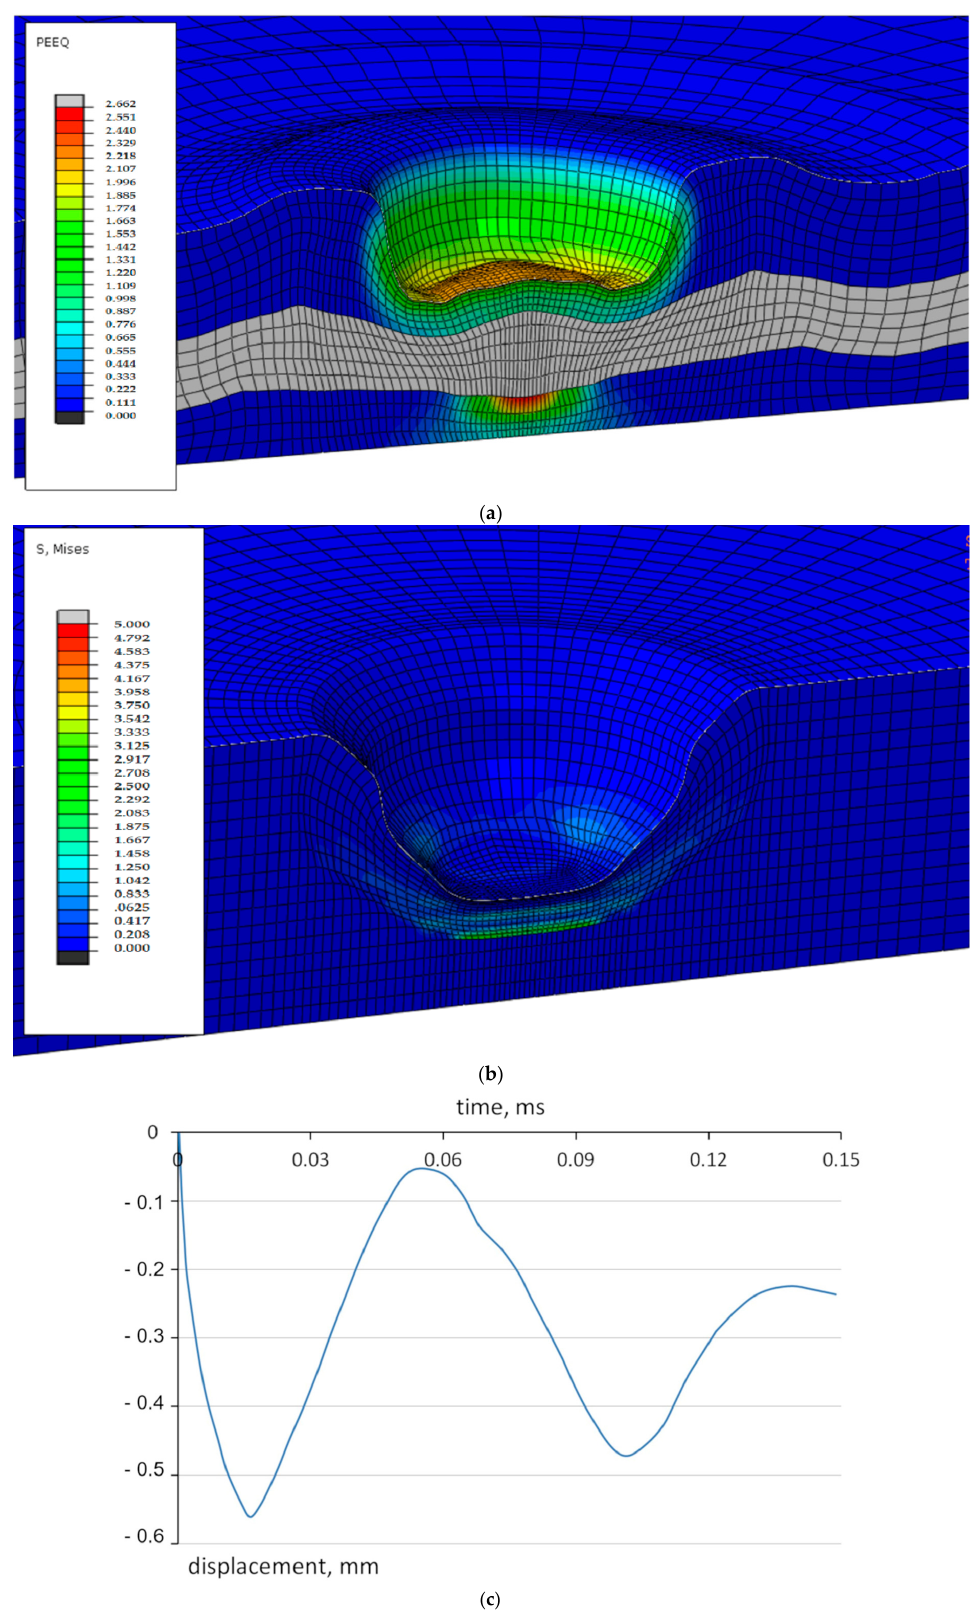
Figure 4. Results of 3D finite element three-layer tissue of animal origin model: ( a ) effective strain distribution—side view in a selected cross-section; ( b ) effective stress distribution—side view in a selected cross-section; ( c ) graph of displacement of central node versus time.